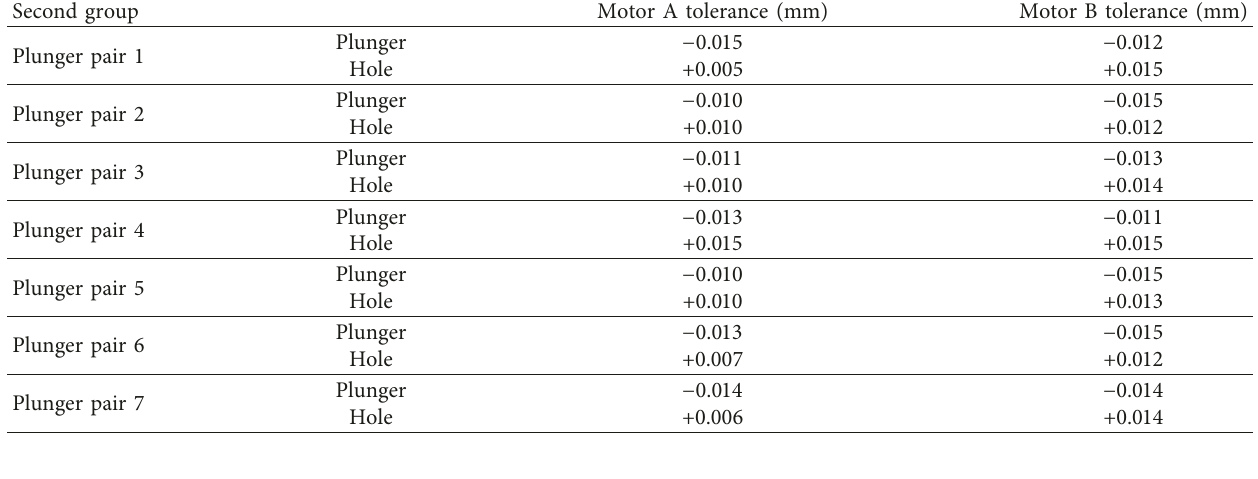
Table 5: The second group of dimensional tolerance table of the testing motor plunger pair.